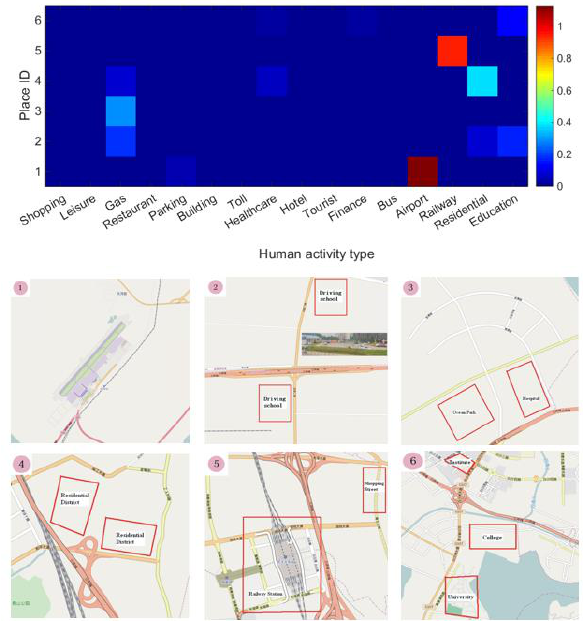
Figure 4. The enhanced urban functionality of the selected natural urban